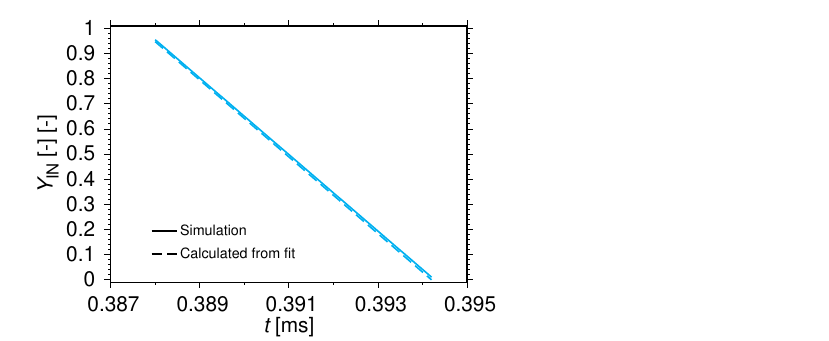
Figure 12. Mass fraction of iron(III) nitrate with time. Initial conditions: r d,0 = 5 µ m, T l,0 = 293.15 K, p = 1 bar, u 0 = 4 m/s, T g,0 = 1200 K, Y C = 0.975, Y IN,0 = 2 H 5 OH,0